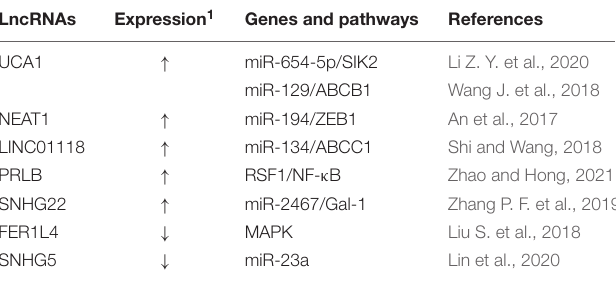
TABLE 5 | LncRNAs and paclitaxel resistance in ovarian